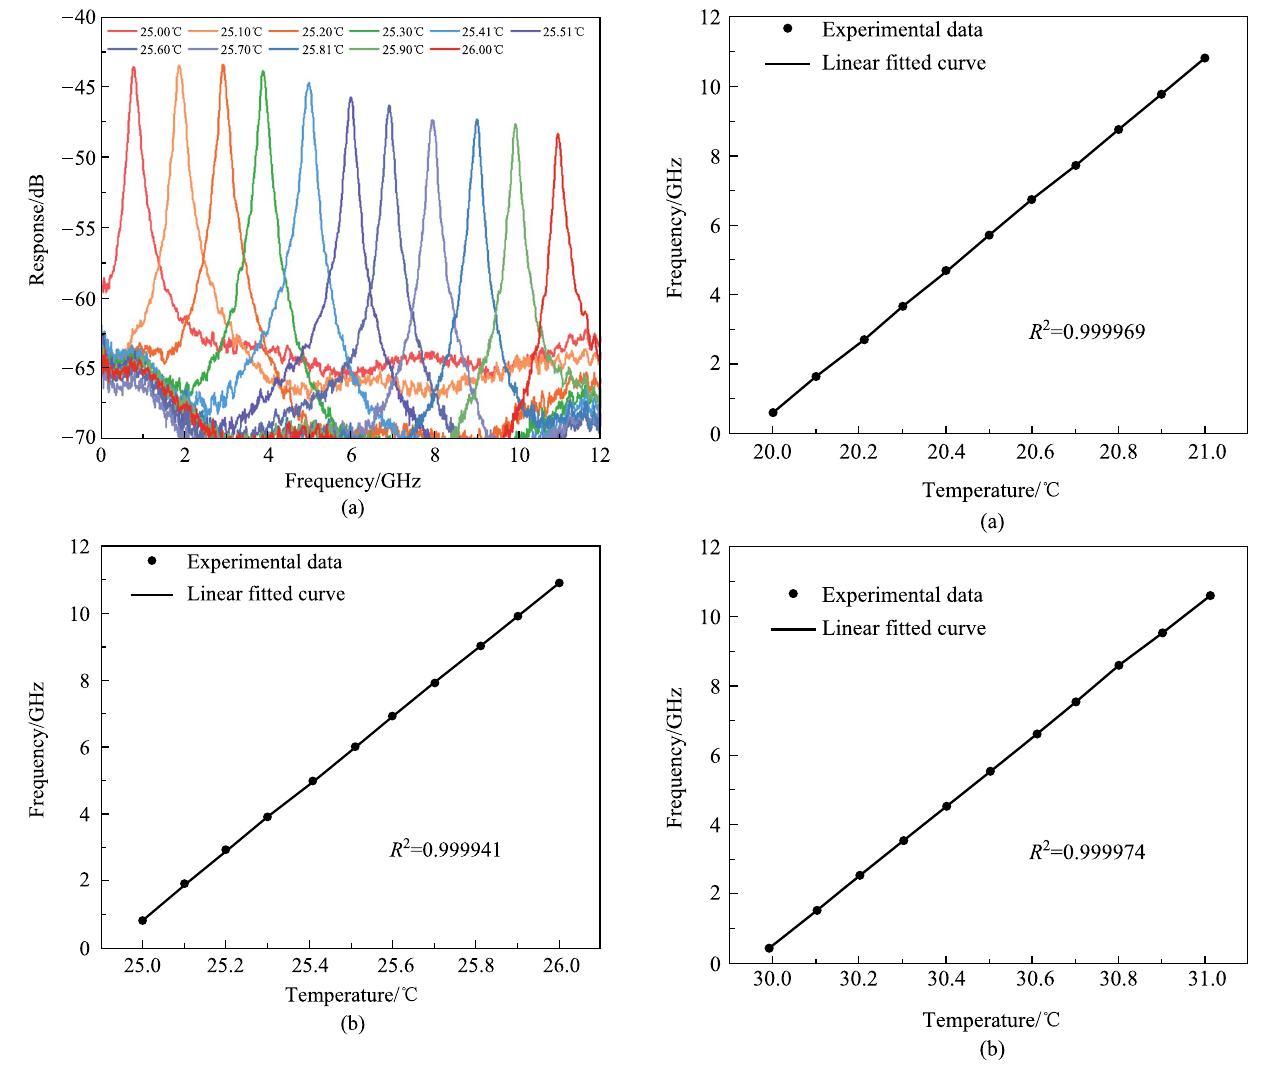
Fig. 7 Measured center frequencies of the MPF versus temperature and the linear fitted curve of the experimental data near the tempera- ture of a 20 °C and b 30